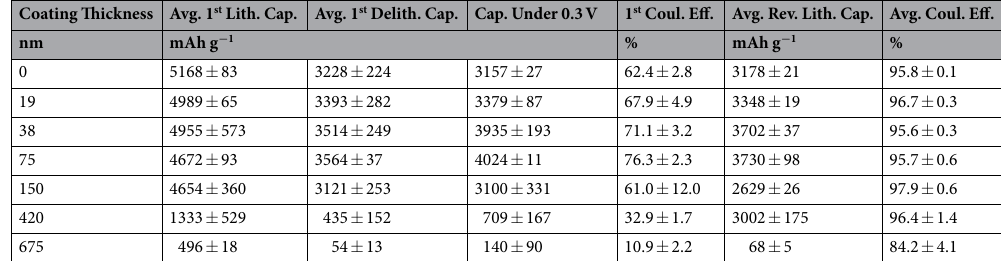
Coating Thickness Avg. 1 st Lith. Cap. Avg. 1 st Delith. Cap. Cap. Under 0.3 V